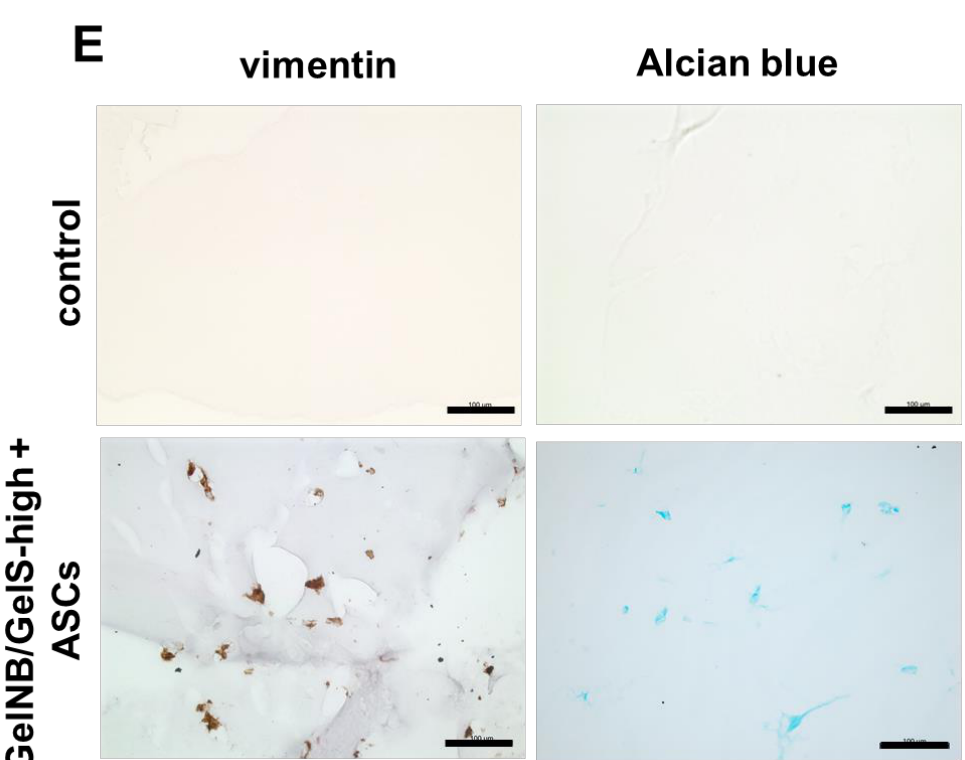
Figure 5. Bioprinting of ASCs in GelNB/GelS-high hydrogel. ( A ) The viability of ASCs was determined 48 h after extrusion-based bioprinting or DoD bioprinting and after manual dispersion of ASCs in GelNB/GelS-high (control) using a live – dead assay. Representative images images from ASCs grown in triplicate in each group are shown (n = 3). Scale bars: 100 µm. ( B ) Quantitative determination of the survival rates via the calculation of the ratio of viable cells to total cells. Shown are means ± SD (n = 3). ( C ) Computer-generated image of the print design for the extrusion-based bioprinting of ASCs in GelNB/GelS-high for implantation. ( D ) Macroscopic image of a representative construct directly after bioprinting. ( E ) Constructs, bioprinted with or without ASCs (control), were incubated in vitro for 3 weeks in chondrogenic differentiation medium. Constructs were paraffin-embedded, sectioned and alcian-blue- or anti-vimentin-stained. Scale bars: 100 µm.